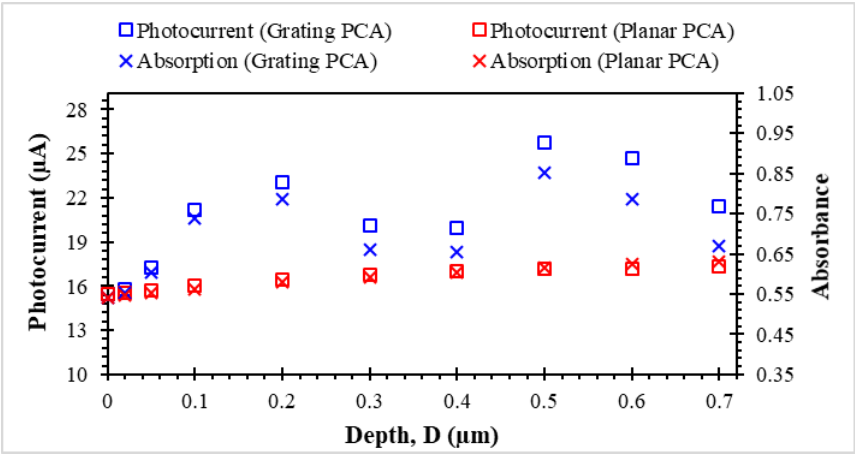
Figure 10. The photocurrent in grating PCA (blue square) and planar PCA (red square) with various D and their corresponding optical absorbance (blue cross for grating PCA and red cross for planar PCA). Note that change in D implies change in the total thickness ( D + H